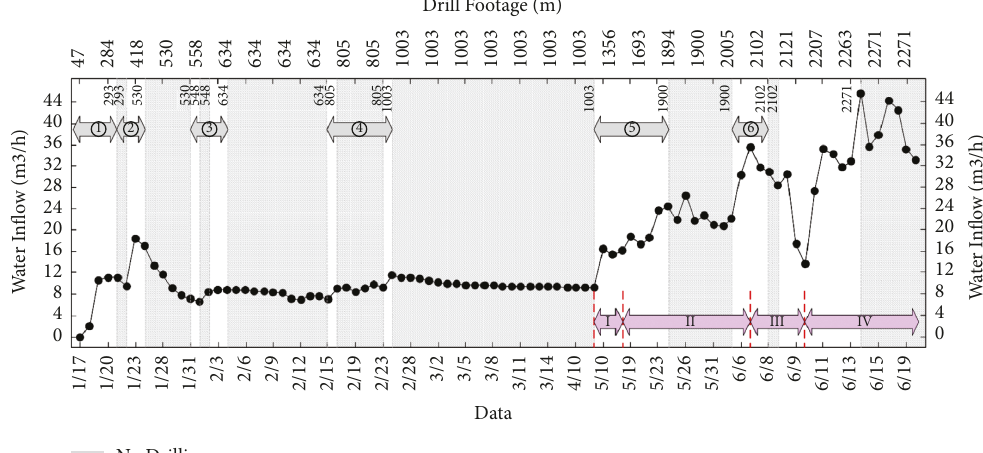
Figure 4: The relationship curve of groundwater inflow in the borehole and the